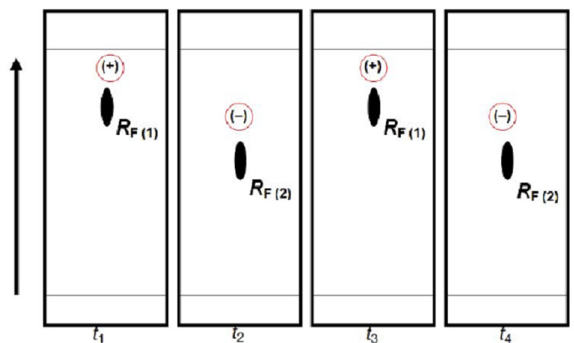
Figure 9. Schematic representation of oscillating changes in R F values for low molecular weight chiral carboxylic acids as function of sample storage time ( t ) in solution. With arrow, direction of growing R F values is indicated, and t 1 , t 2 , t 3 , and t 4 denote consecutive storage time steps of investigated sample [178].